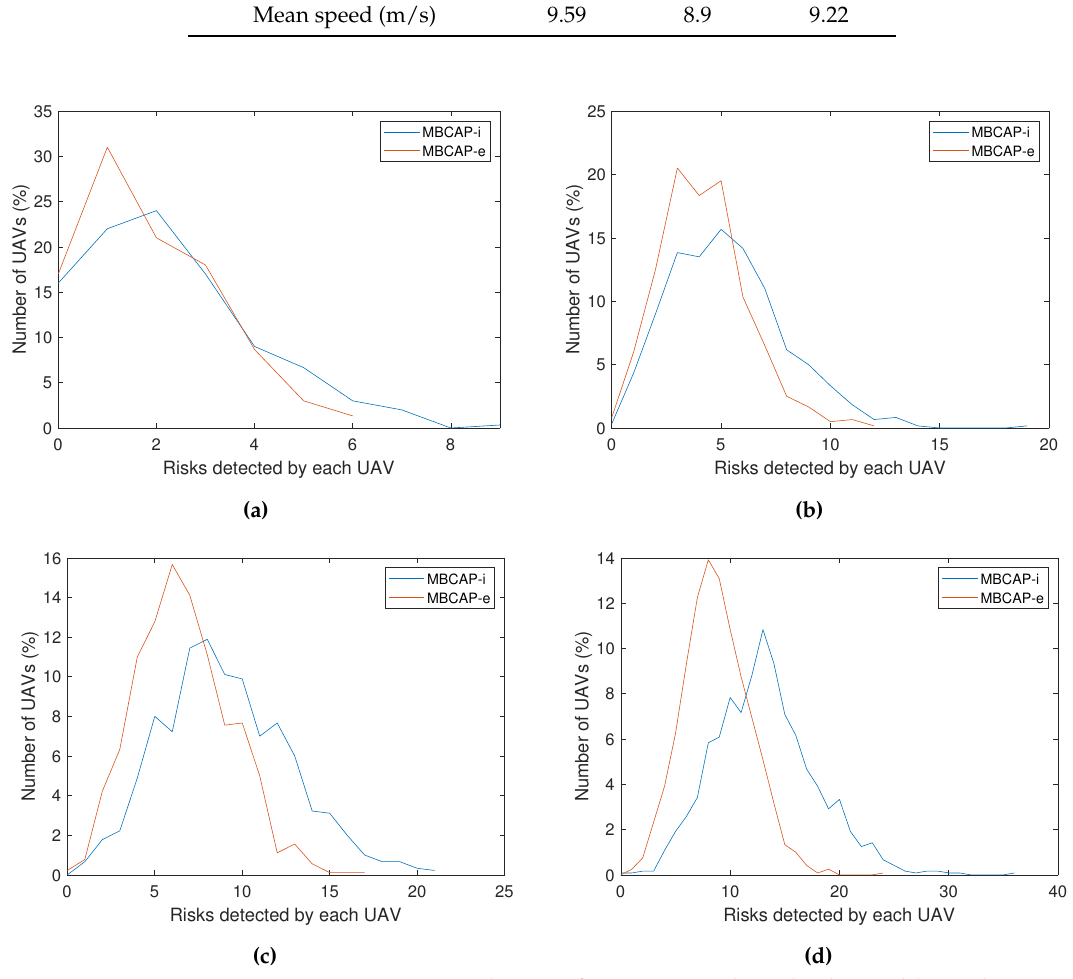
Figure 17. MBCAP-i vs. MBCAP-e: Distribution of UAVs given the risks detected by each one. ( a ) Experiment with 25 UAVs. ( b ) Experiment with 50 UAVs. ( c ) Experiment with 75 UAVs. ( d ) Experiment with 100